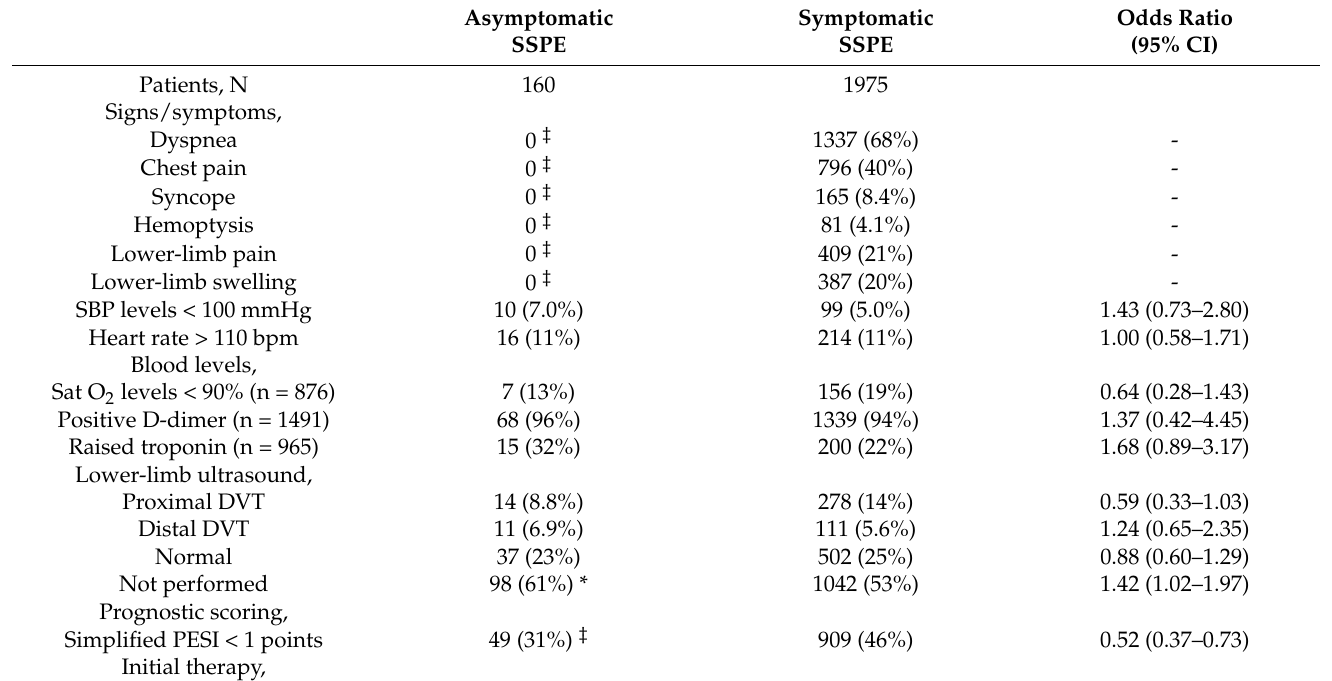
Table 2. Signs, symptoms, diagnostic tests, and therapeutic strategies.